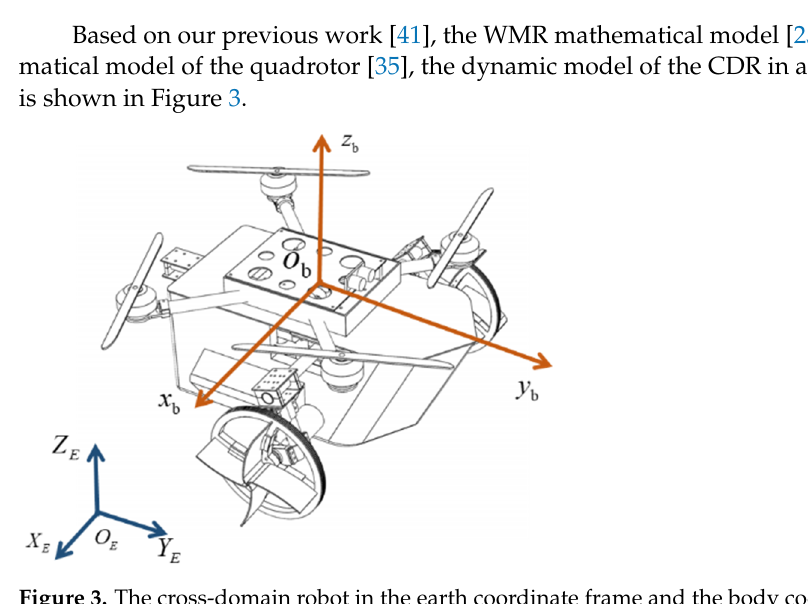
Figure 3. The cross-domain robot in the earth coordinate frame and the body coordinate frame. As shown in Figure 3, ( , , , ) E O X Y Z is the earth coordinate frame. ( , , , ) b o x y z is the body coordinate frame. The robot position on the water surface is defined as = T x y z . The attitude angle of robot in the earth coordinate frame is defined as = T